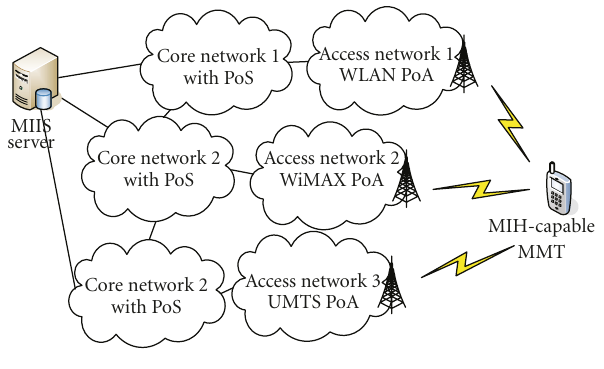
Figure 2: Network model with MIH